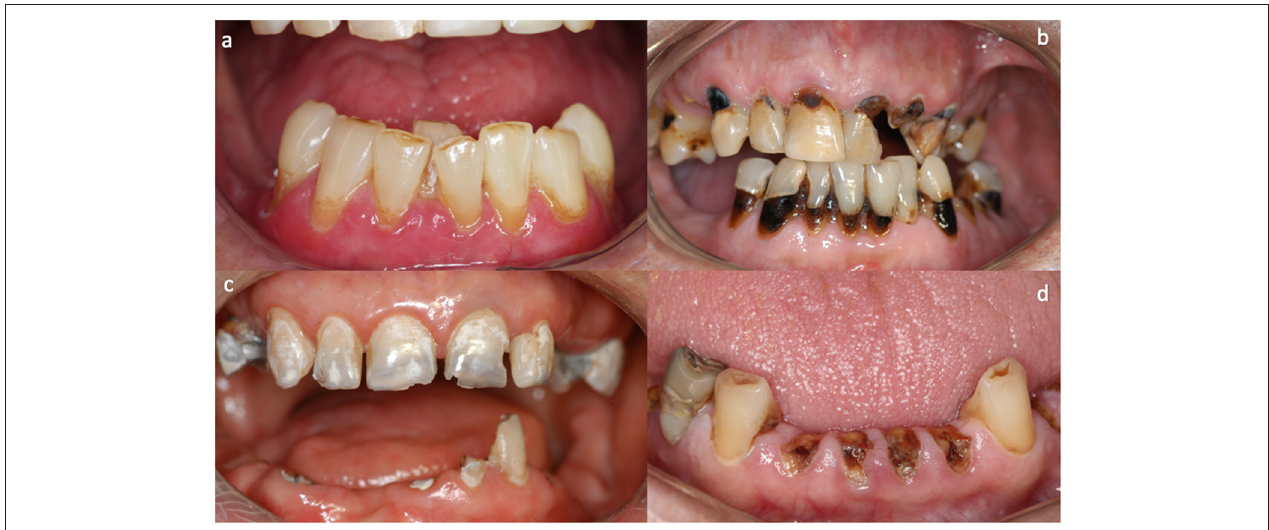
FIGURE 2 | Radiation caries clinical stages. (A,B) Representation of incipient radiation caries with presence of superficial enamel changes with brownish pigmentation on the smooth surfaces. (C) Demineralization and delamination enamel spots representing the second stage. (D) Crown amputation is the last stage of radiation caries with progressively faster